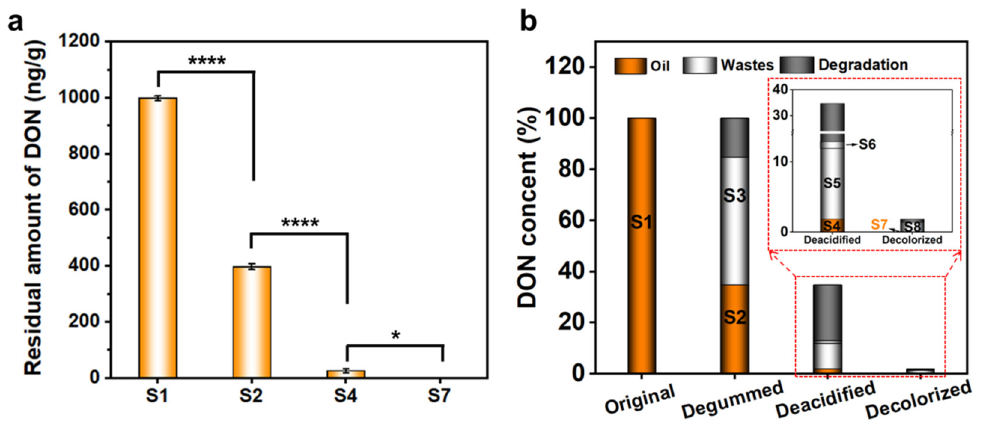
Figure 2. The transfer law of DON in the germ oil refining process. ( a ) The residual amount of DON in the crude oil (S1), degumming oil (S2), deacidified oil (S4), and decolorized oil (S7). The data are expressed as the mean ± SEM (standard error of mean). * p < 0.05, **** p < 0.0001 ( b ) The residual rates of DON in the germ oil continuous refining process. Each data point and error bar represent the mean and standard deviation from at least three independent